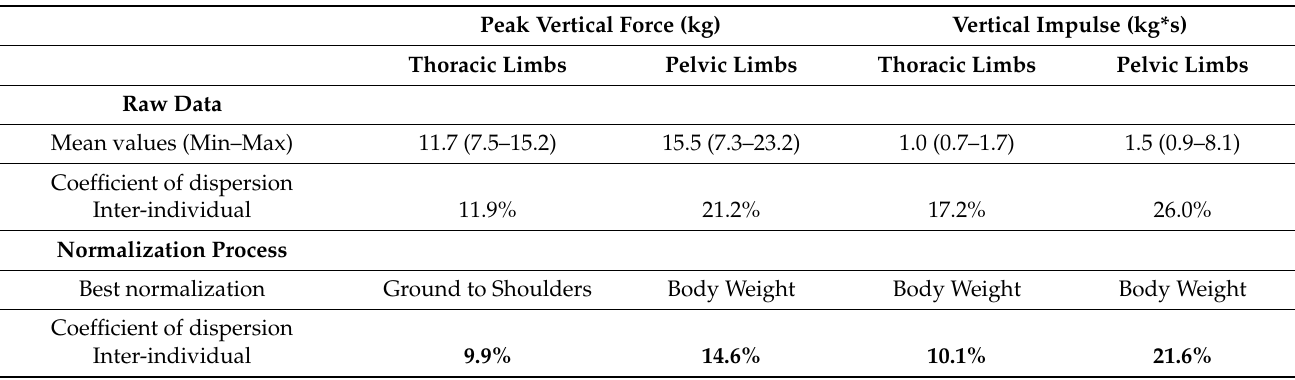
Table 2. Best normalization process for Effort Path values.